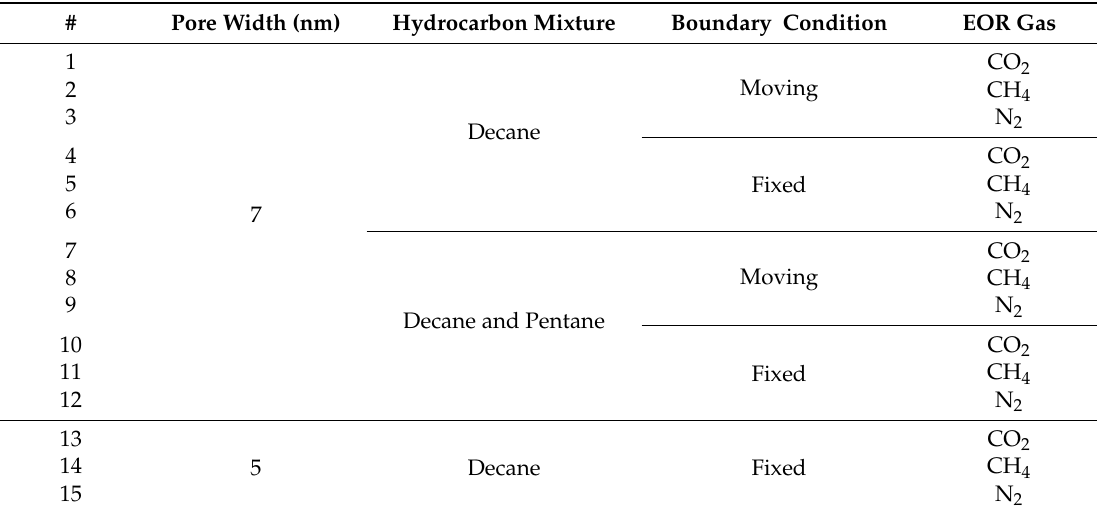
Table 2. Simulation matrix of the scenarios